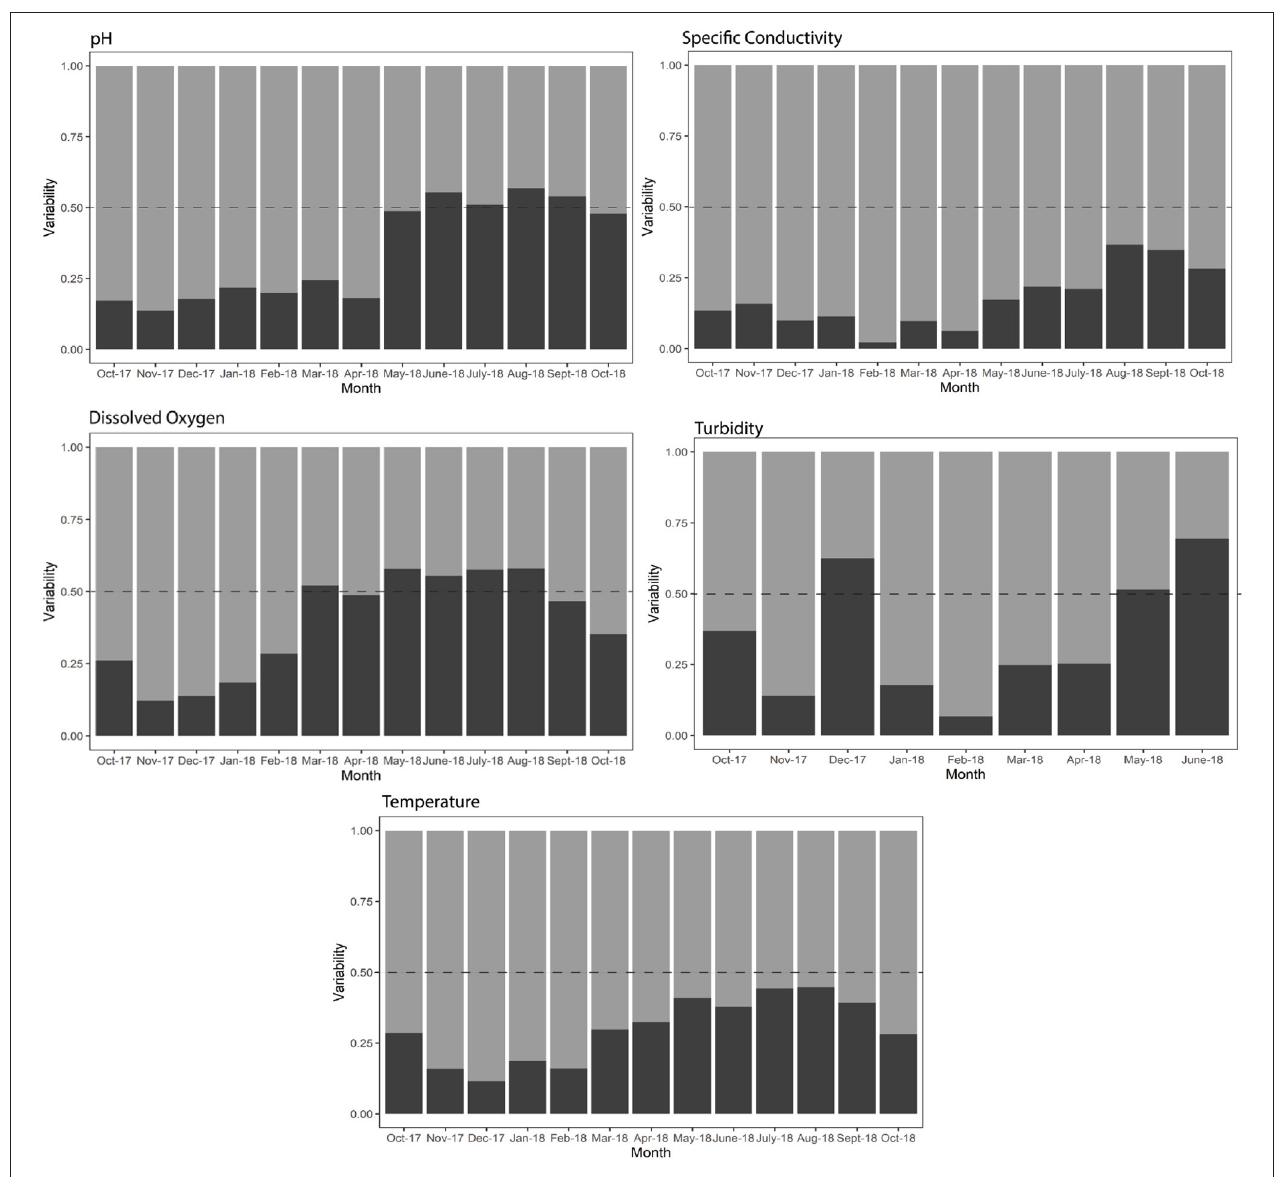
FIGURE 6 | Monthly intercycle (i.e., non-tidal) and intracycle (i.e., tidal) variability for pH, turbidity, dissolved oxygen, specific conductivity, and temperature in the Union River shown as relative proportion for each month. The dashed line indicates a relative proportion of 0.50: i.e., intra-and intercycle variability for that month were equal. Intracycle variability > 0.5 (above the dashed line) indicates that tidal variability was dominant, whereas intracycle variability < 0.5 (below the dashed line) indicates that non-tidal variability was dominant. Intracycle variability is calculated as the monthly average of tidal cycle standard deviations for each parameter. Intercycle variability is calculated as the monthly standard deviation of tidal cycle